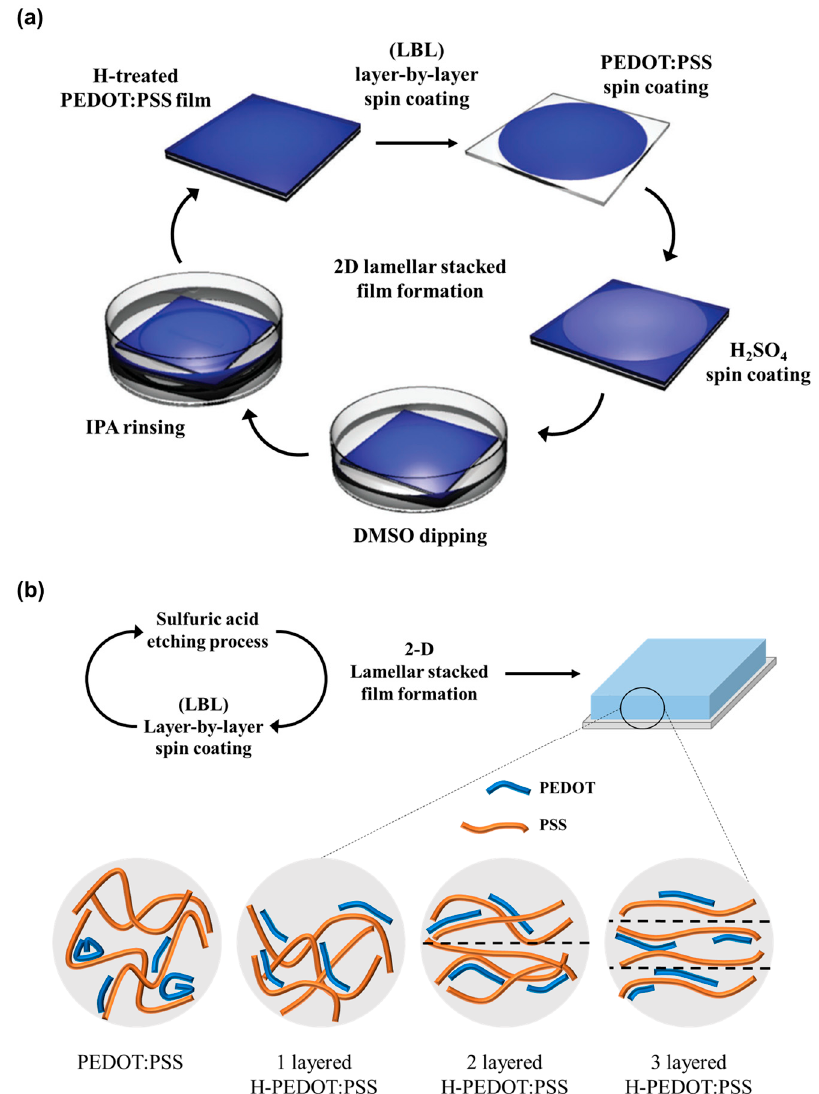
Lamellar stacked structure of H-Poly(3,4-ethylenedioxythiophene):poly(styrenesulfonate) (PEDOT:PSS) film through H 2 SO 4 /DMSO post-treatment and layer-by-layer (LBL)